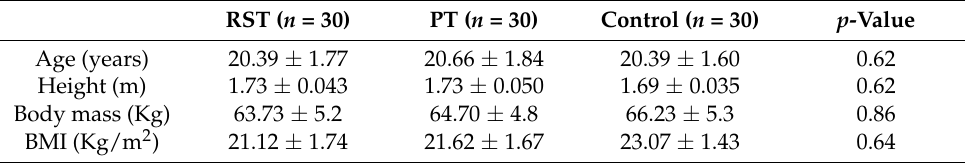
Table 1. Characteristics of the participants in both the experimental and control groups. RST ( n = 30) PT ( n = 30) Control ( n = 30) p -Value Age (years) 20.39 ±